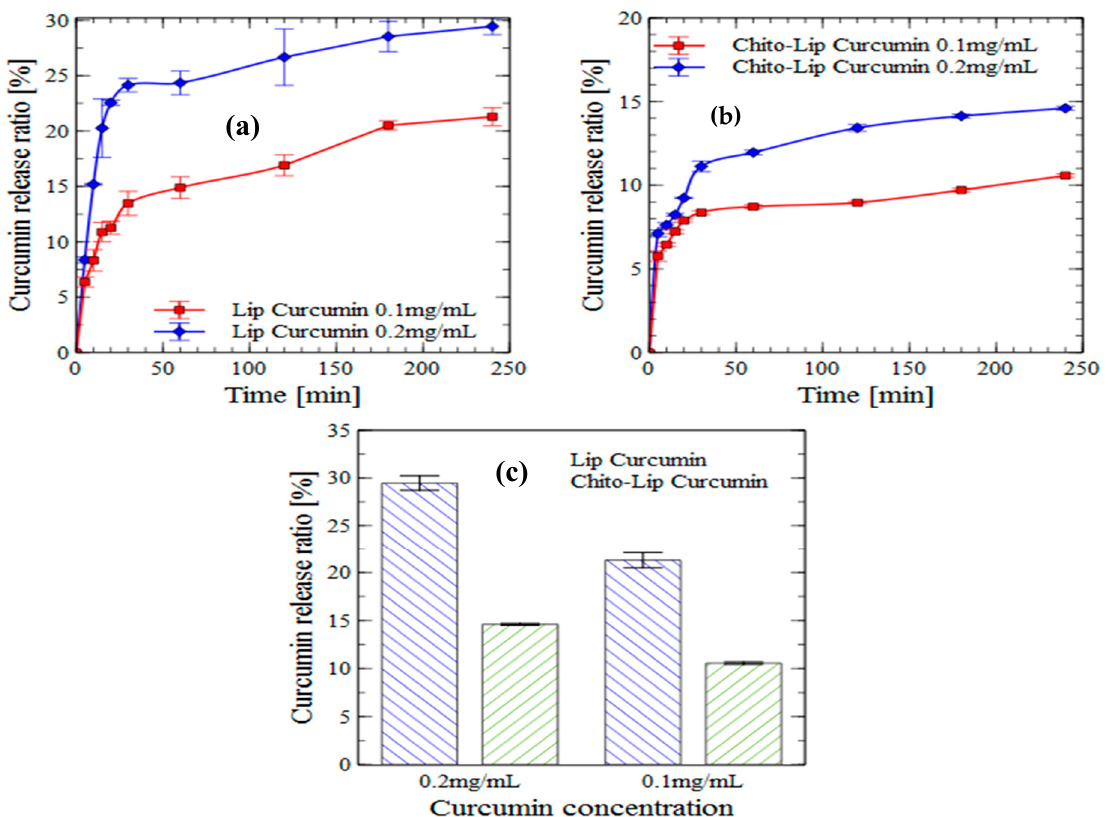
Figure 4. In vitro release (intestinal digestion) of curcumin encapsulated in nanoliposomes ( a ) and chitosan-coated nanoliposomes ( b ) (values reported are mean ± SD; n = 3), and the proportions of released curcumin from nanoliposomes and chitosan-coated nanoliposomes after four hours of incubation ( c ).